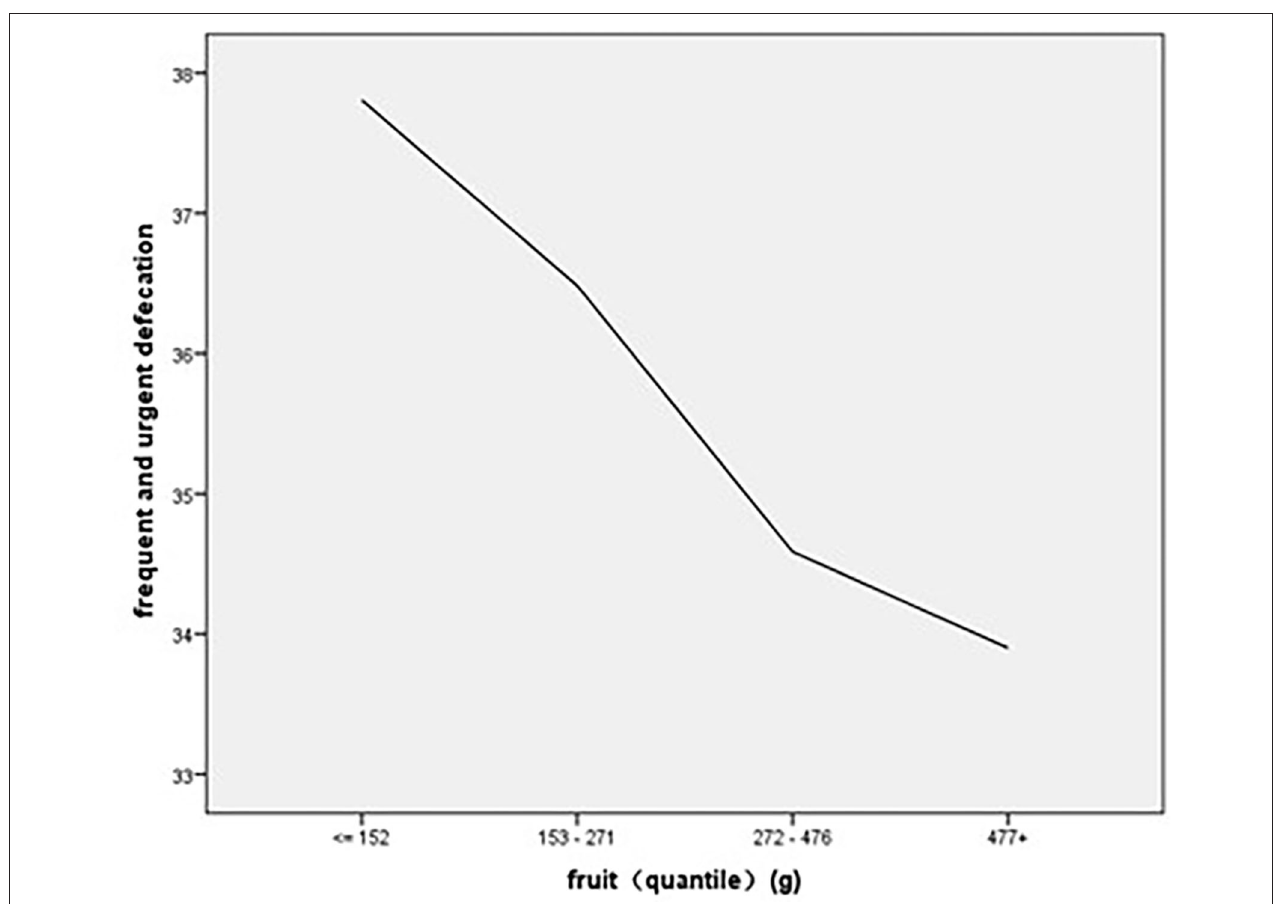
FIGURE 3 | The association of stratified quintiles of consumption of fruits with frequent and urgent defecation.